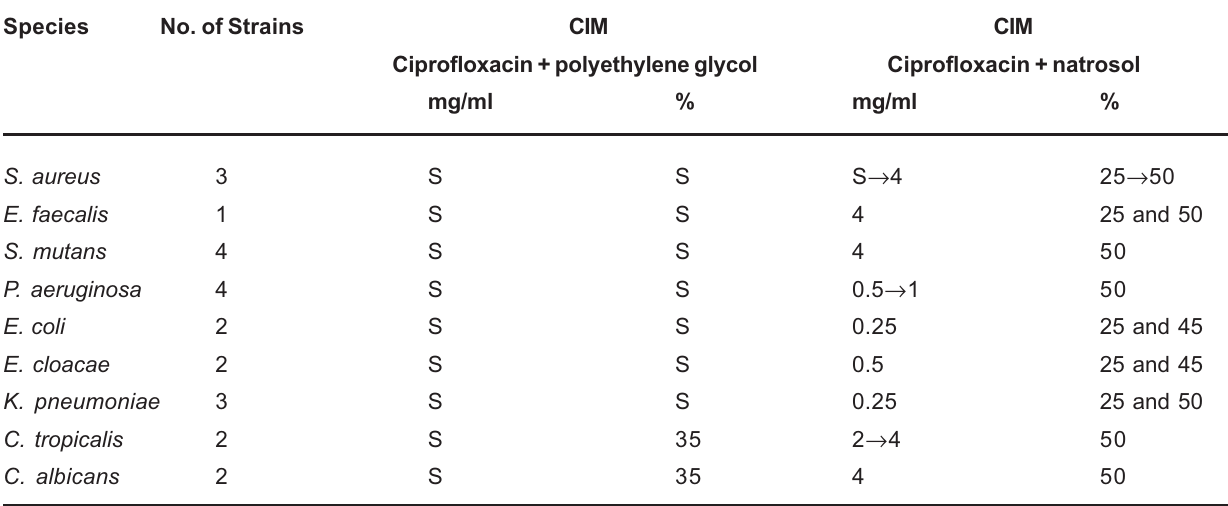
S = sensitive at the lowest concentration tested (0.25 µ g/ml or 25%); → interval of concentration of the tested